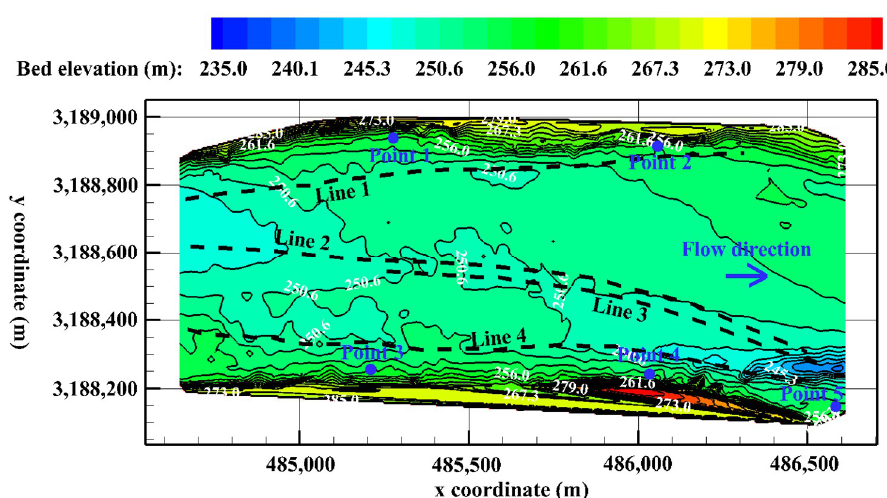
Figure 3. The double-spur dikes constructed on the target reach.